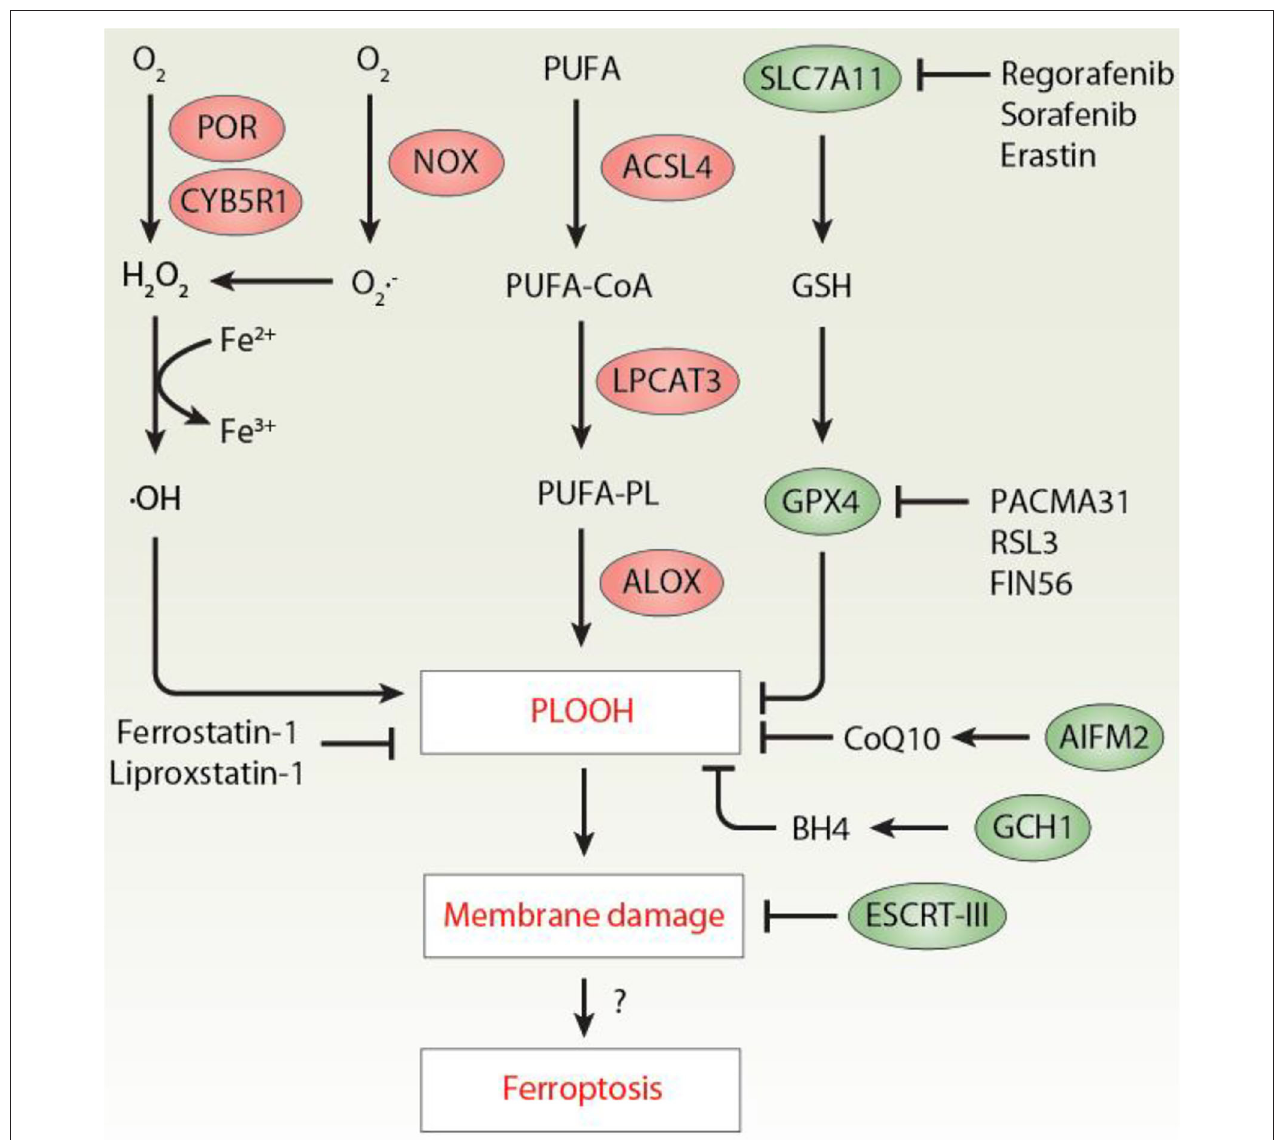
FIGURE 1 | The mechanism of lipid peroxidation in ferroptosis. Excessive lipid peroxidation plays an important role in promoting ferroptosis by producing toxic PLOOH. At least three pathways mediated by POR/CYB5R1, NOX, and ALOX contribute to PLOOH production. In contrast, activation of the SLC7A11-GSH-GPX4, AIFM2-CoQ10, GCH1-BH4 axis limits lipid peroxidation during ferroptosis. In addition, PLOOH-mediated membrane damage can be repaired by the ESCRT-III membrane scission complex. ACSL4, acyl-CoA synthetase long-chain family member 4; AIFM2/FSP1, apoptosis inducing factor mitochondria associated 2; BH4, tetrahydrobiopterin; CoQ10, coenzyme Q10; CYB5R1, cytochrome B5 reductase 1; ESCRT-III, endosomal sorting complex required for transport-III; GCH1, GTP cyclohydrolase 1; GPX4, glutathione peroxidase 4; GSH, glutathione; H 2 O 2 , hydrogen peroxide; PLOOH, phospholipid hydroperoxide; POR, cytochrome